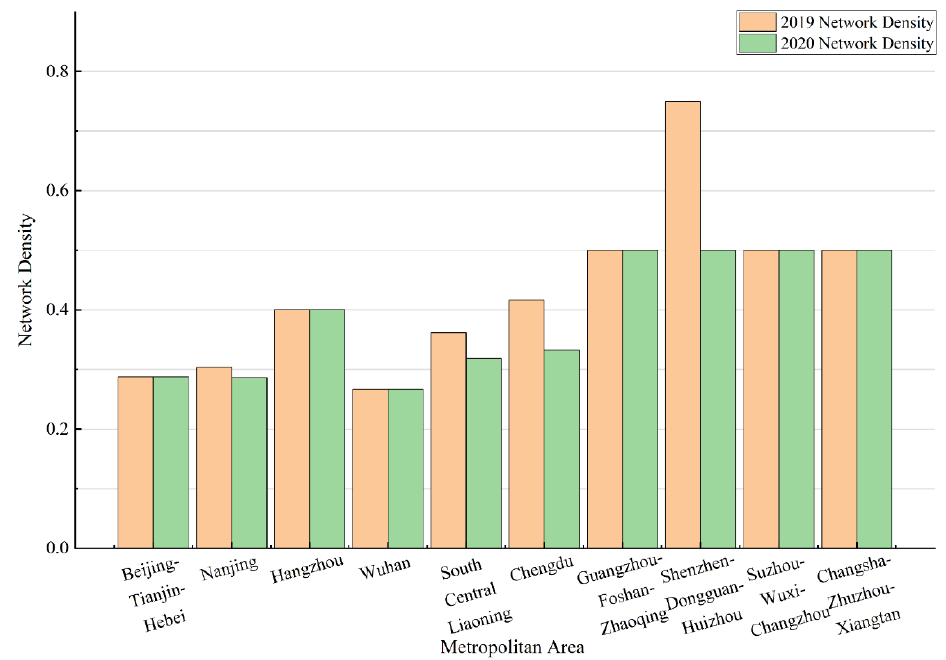
Figure 3. Network density of PM 2.5 spatial correlation networks in ten metropolitan areas in 2019–